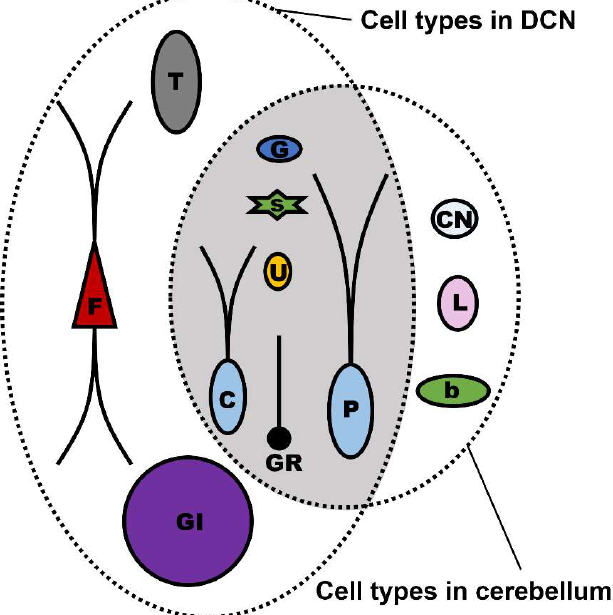
Figure 4. Common cell types (highlighted in the grey overlapped region) in DCN and cerebellum. The granule cells and unipolar brush cells are classified shared excitatory cell types in DCN and cerebellum. Purkinje-like cartwheel cells or Purkinje cells, Golgi cells, and stellate cells are shared inhibitory cell types. F, fusiform cell; GI, giant cell; T, tuberculoventral cell; C, cartwheel cell; G, Golgi cell; s, stellate cell; U, unipolar brush cell; GR, granule cell. P, Purkinje cell; CN, candelabrum cell; L, Lugaro cell; b, basket cell.